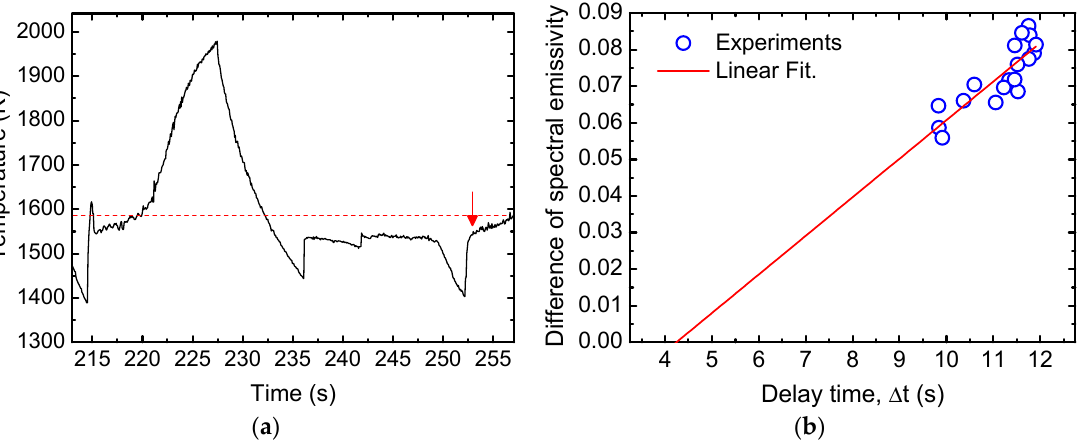
Figure 6. ( a ) Time-temperature profile of a CoSi-62 at. % alloy with a short delay time. No temperature drop (marked by a red arrow) is observed on the subsequent heating curve. ( b ) Relation between delay time and change of spectral emissivity. The emissivity change for the temperature drop was calculated by assuming the emissivity of the liquid phase to be 0.25.